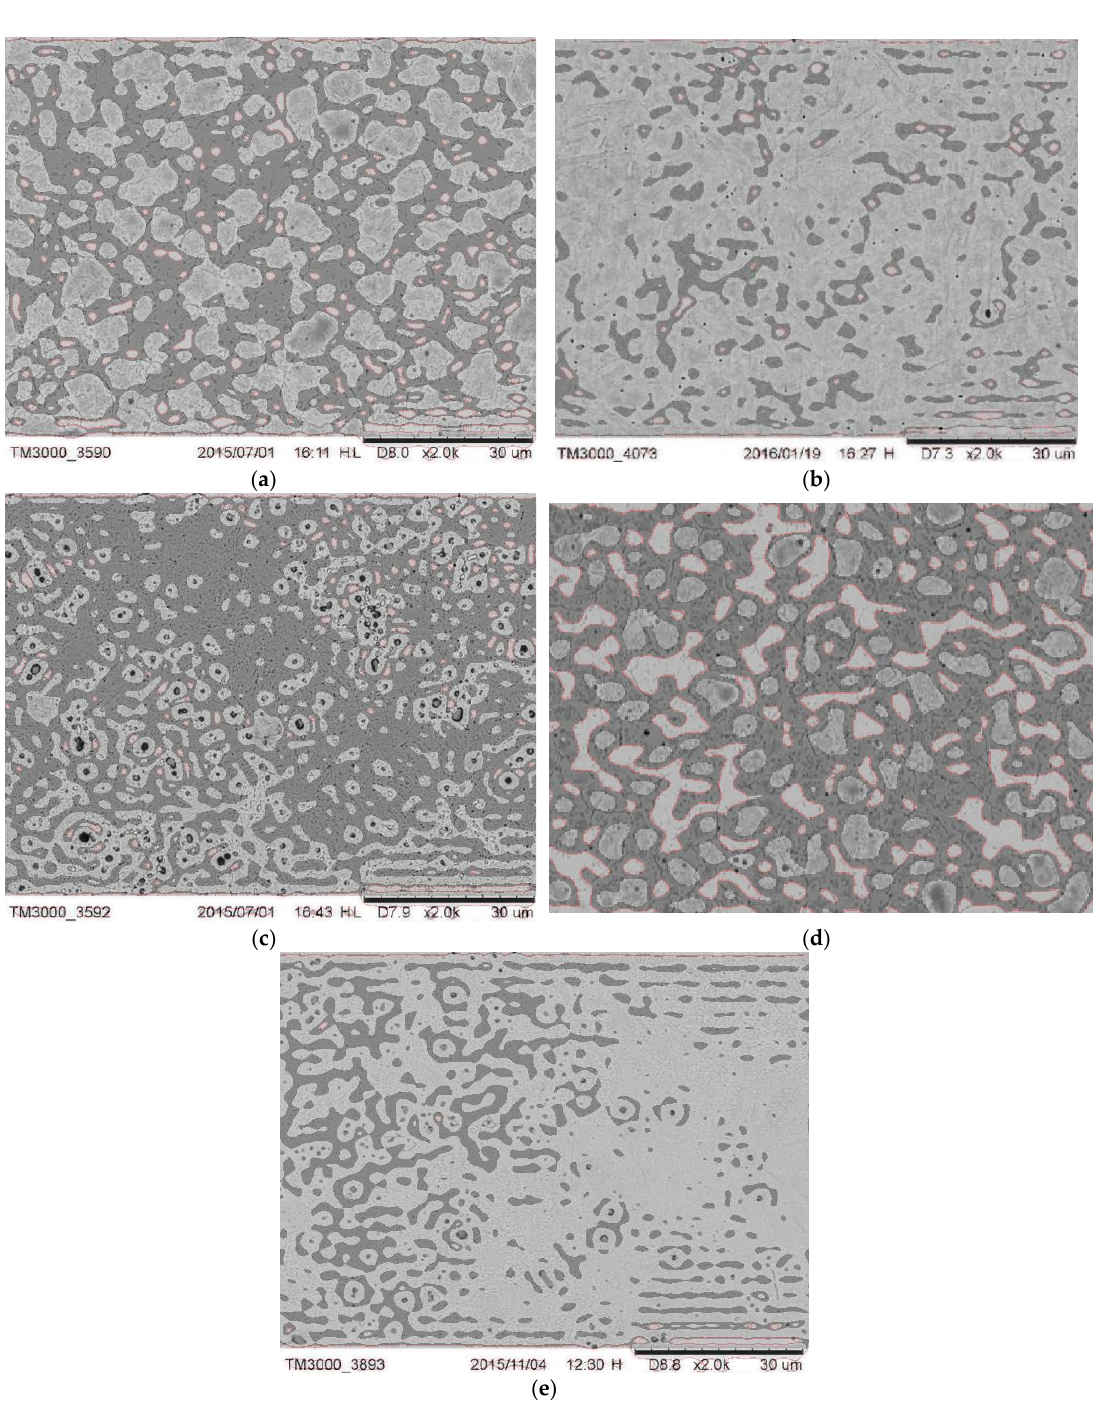
Figure 7. ( a ) Two-dimensional processing image of the A drill microstructure; ( b ) two-dimensional processing image of the B drill microstructure; ( c ) two-dimensional processing image of the C drill microstructure; ( d ) two-dimensional processing image of the D drill microstructure and ( e ) two- dimensional processing image of the E drill microstructure. Table 3 . Descriptives for the contrast, energy, homogeneity and correlation values of the implant drill microstructure images examined. Group Descriptives Implant drills